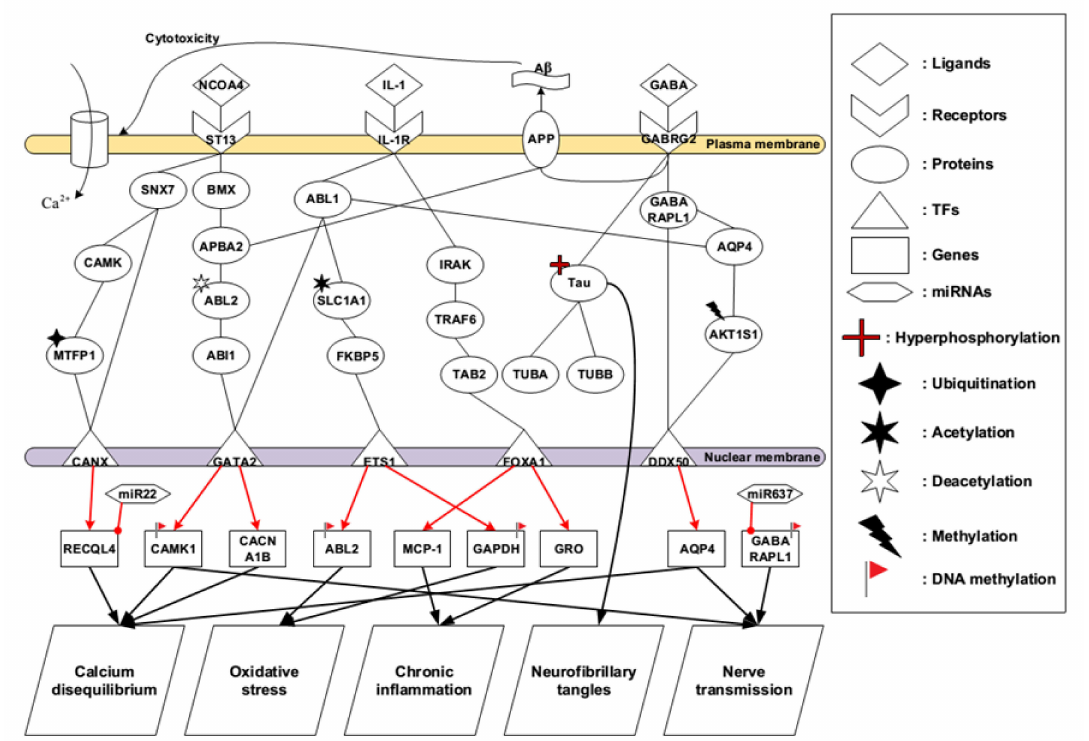
Figure 3. The core pathways in the early-stage AD. The core members were extracted from the core GENs in Figure 2A, showing the molecular mechanism to regulate the early events in AD. Calcium disequilibrium, oxidative stress, chronic inflammation, hyperphosphorylated tau protein, and nerve transmission are shown to onset in the very beginning of AD. The black lines indicate the protein-protein interaction; the red lines with arrowhead denote the regulation from upstream to downstream; the final cellular functions are mediated by target genes. Notations of genetic and epigenetic regulations are listed at the right